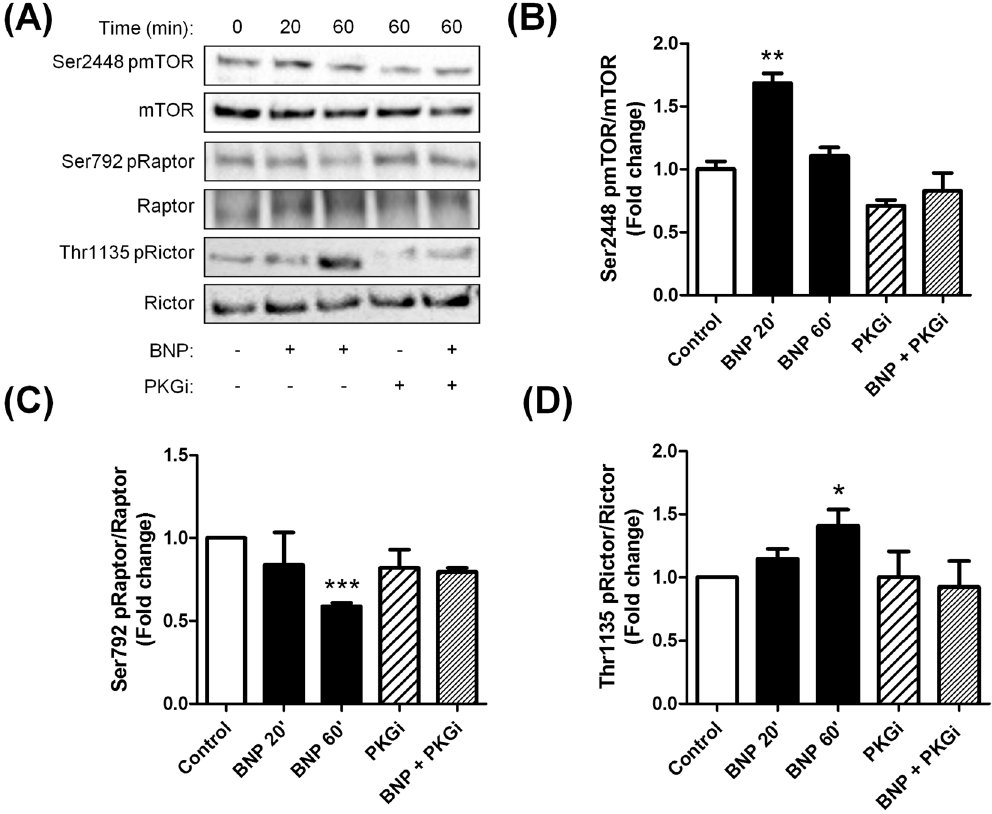
Figure 5. Natriuretic peptides activate mTOR-signalling in a cGMP-dependent manner in hMADS adipocytes. Representative blots ( A ) and quantitative bar graphs of mTOR Ser2448 phosphorylation relative to total mTOR ( B ), Raptor Ser792 phosphorylation relative to total Raptor ( C ), Rictor Thr1135 phosphorylation relative to total Rictor ( D ), in response to 20 min and 60 min treatment with BNP 100 nM in absence or presence of (Rp)- 8-pCPT-cGMPS 100 µ M (PKG inhibitor, PKGi). * p < 0.05, ** p < 0.01, *** p < 0.0001 vs. control (n =